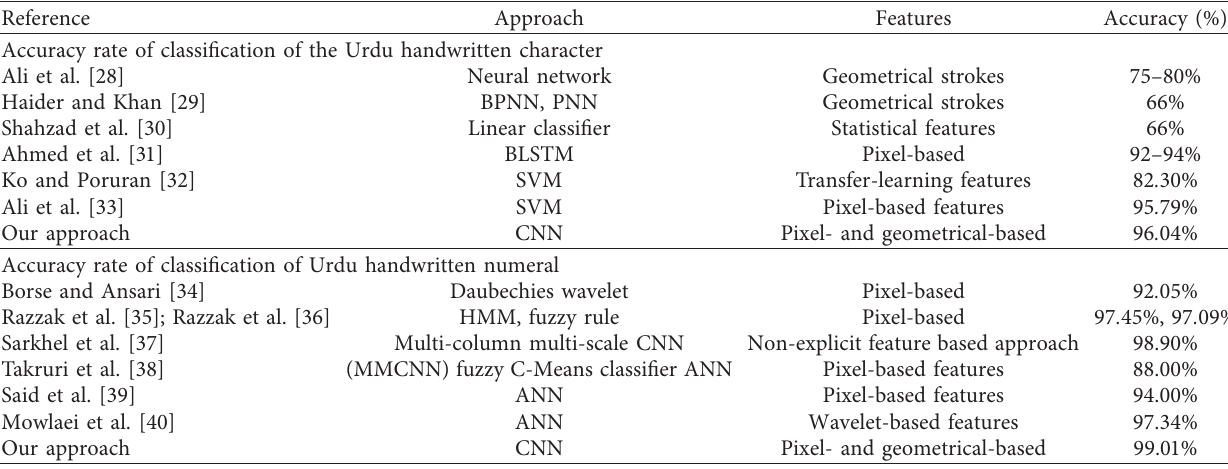
Table 5: Comparison Analysis of our proposed approach for Urdu handwritten character classification with state-of-the-art approaches.